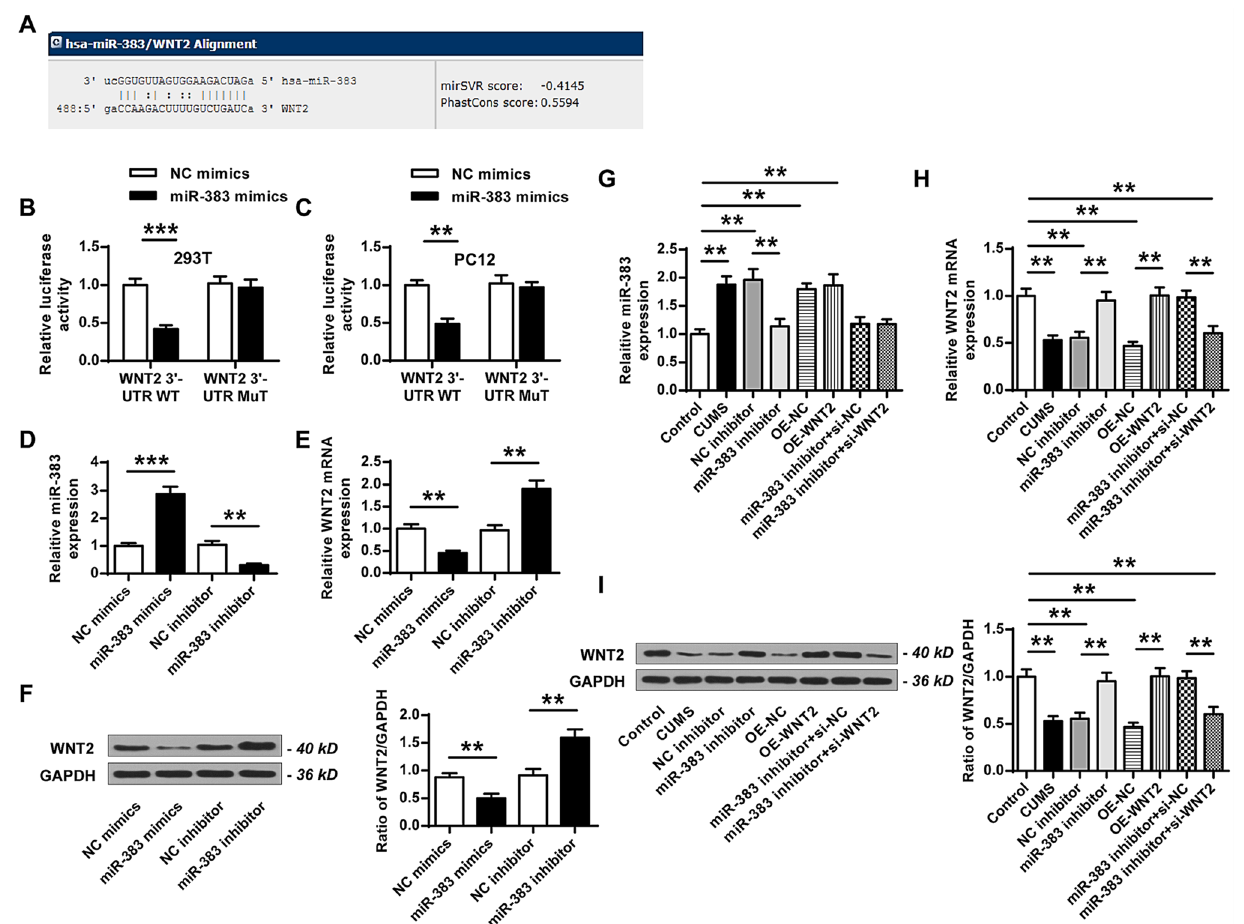
Figure 2. WNT2 was a target of miR-383. ( A ) The results of biological prediction between miR-383 and Wnt2. ( B , C ) The relative luciferase activity of WT or MUT 3 ′ -UTR of Wnt2 in 293 T cells ( B ) and PC12 cells ( C ) transfected with miR-383 mimics or NC mimics was evaluated by the dual luciferase reporter system (n = 3). ( D – F ) The PC12 cells were transfected with NC mimics, miR-383 mimics, NC inhibitor or miR-383 inhibitor. ( D ) Transfection efficiency of miR-383 mimics/inhibitor in the PC12 cells was evaluate by qRT-PCR (n = 3). ( E ) The mRNA level of Wnt2 in PC12 cells was detected by qRT-PCR (n = 3). ( F ) The protein level of Wnt2 in PC12 cells was evaluated by western blot (n = 3). ( G – I ) Rats were injected with miR-383 inhibitor, NC inhibitor, OE-NC (the negative control of Wnt2 overexpression), OE-Wnt2 (Wnt2 overexpression), miR-383 inhibitor plus si-NC (the negative control of Wnt2 silencing) or miR-383 inhibitor plus si-Wnt2 (Wnt2 silencing), and then submitted to CUMS. ( G ) The mRNA level of miR-383 in hippocampal tissues was evaluated by qRT-PCR (n = 6). ( H , I ) The mRNA level ( H ) and protein level ( I ) in hippocampal tissues were evaluated by western blot (n = 6). Data were presented as mean ± SD and each experiment was repeated three times. ** P < 0.01, *** P <